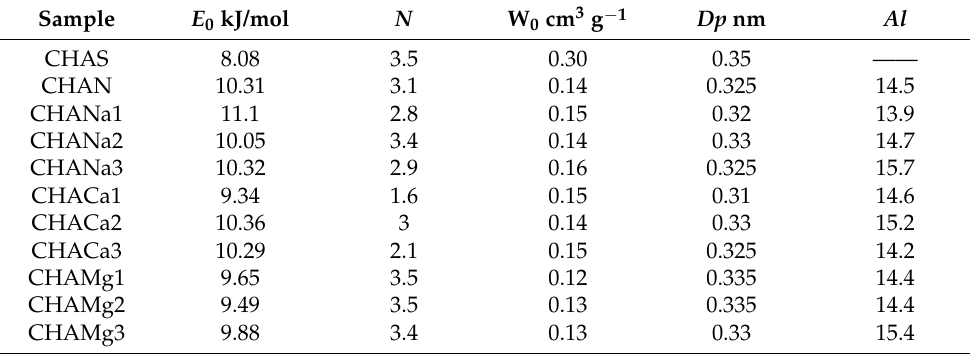
Table 5. Parameters of micropores of chabazite zeolites, Dubinin–Astakhov equation. Sample